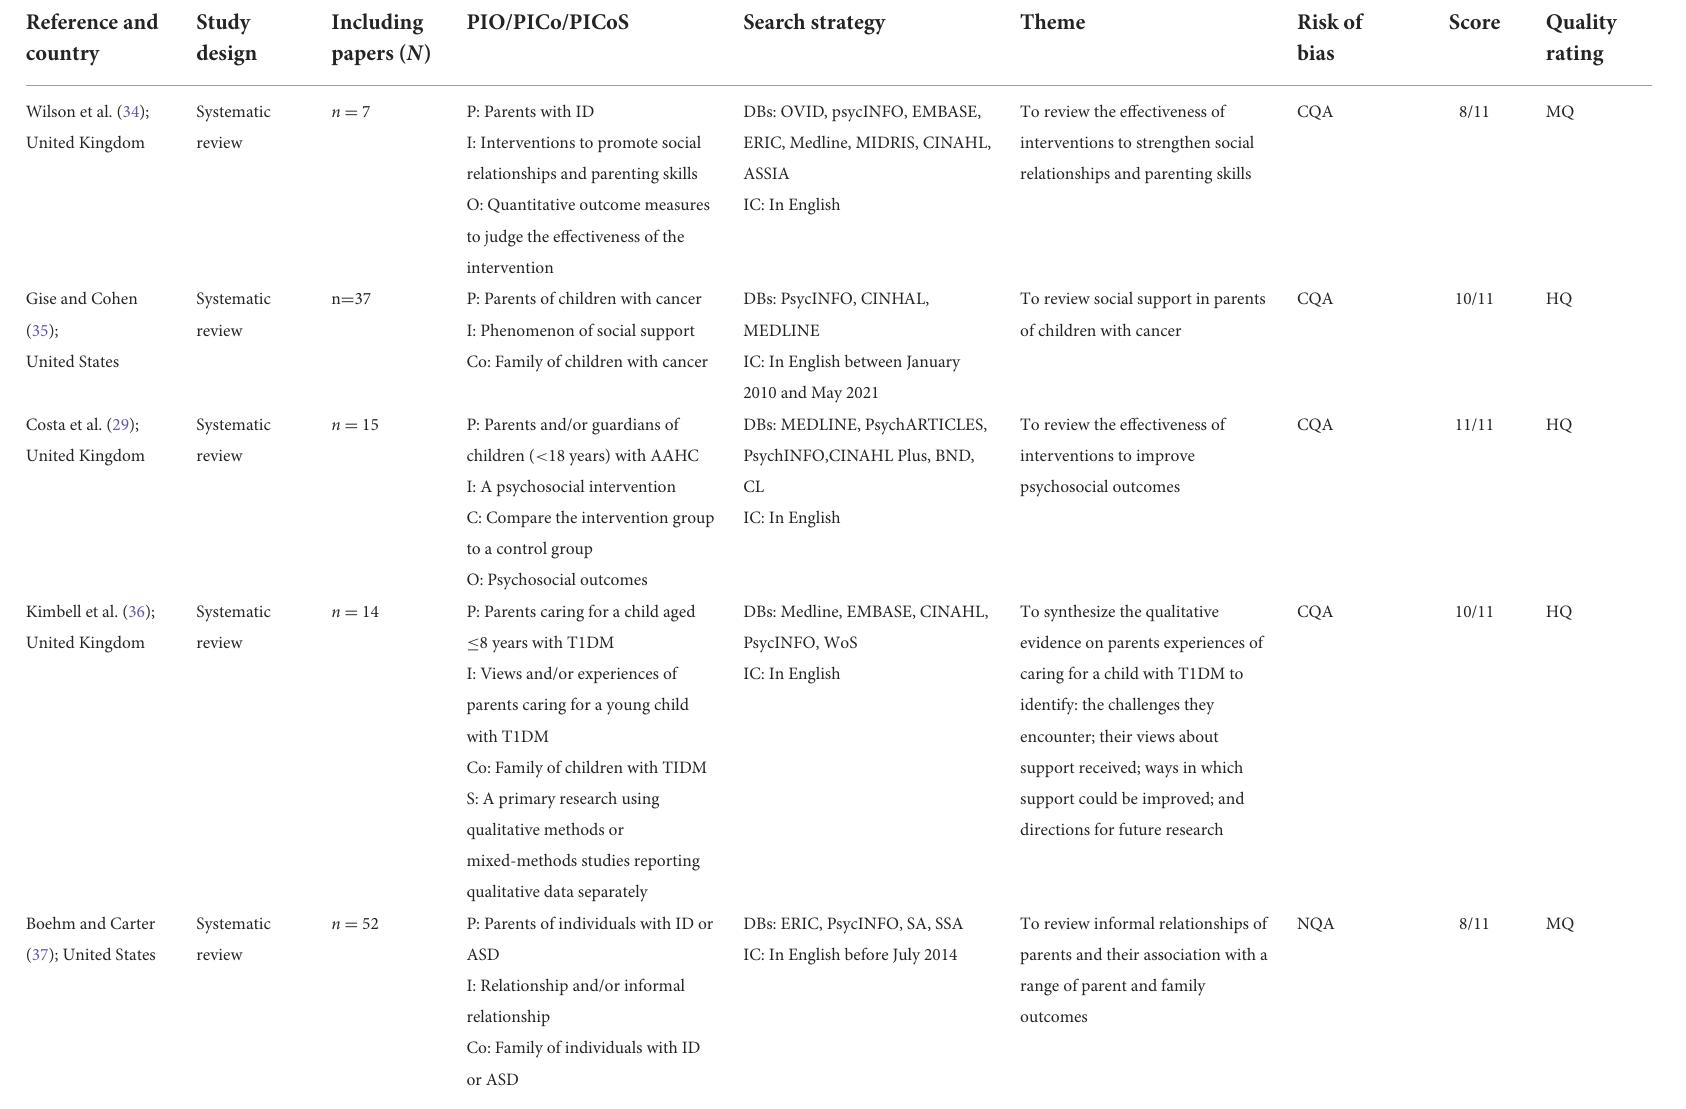
TABLE 1 Characteristics of included